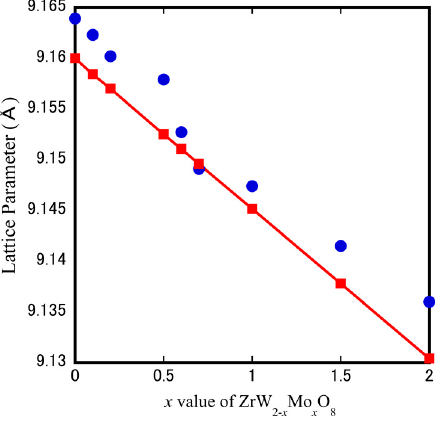
Figure 8. XRD results of cubic-ZrW 2 − x Mo x O 8 bulk ceramics.